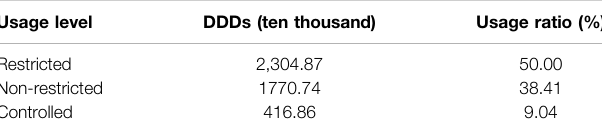
TABLE 8 | Percentage of antibiotic classes used by different usage levels, 2016 –